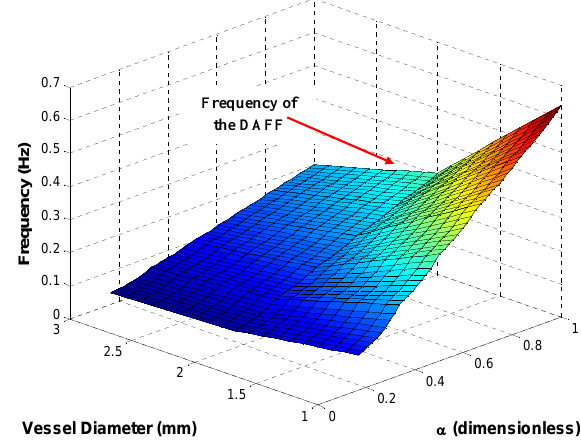
Figure 6. Frequency and asymmetry ratio α for high targeting performance in bifurcations of different